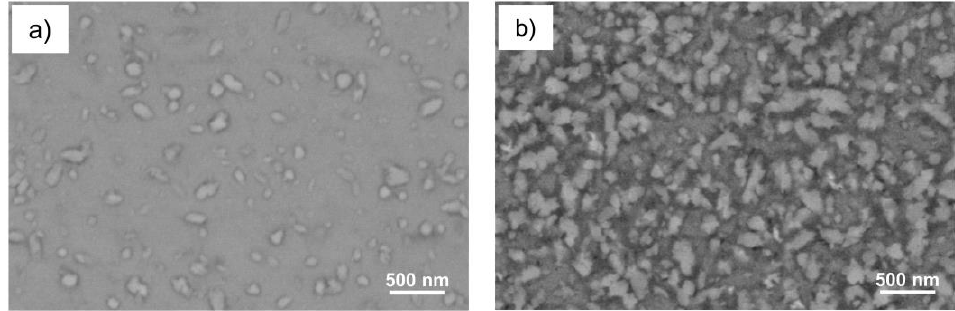
Figure 4. SEM images of the samples annealed at 1025 K for ( a ) 50 min, ( b ) 100 min. It was found that the volume fraction of CoWB is 0.12. It was also determined that the average particle size of CoWB precipitates is 74 nm. The 100 min annealed sample contains the Ni-phase, CoWB, and Ni 3 Ta. The compositions of the Ni-phase and Ni 3 Ta are the same, so they have the same average atomic number per unit volume (Table 3). For this reason, it is not possible to distinguish these two phases in the SEM image obtained with the BSE mode. Only the CoWB phase, which has the highest average atomic number per unit volume, can be distinguished from the others. The volume fraction of CoWB was determined to be 0.35, which is consistent with the result obtained from the Rietveld refinement. In addition, it was determined that the average grain size of the CoWB was 86